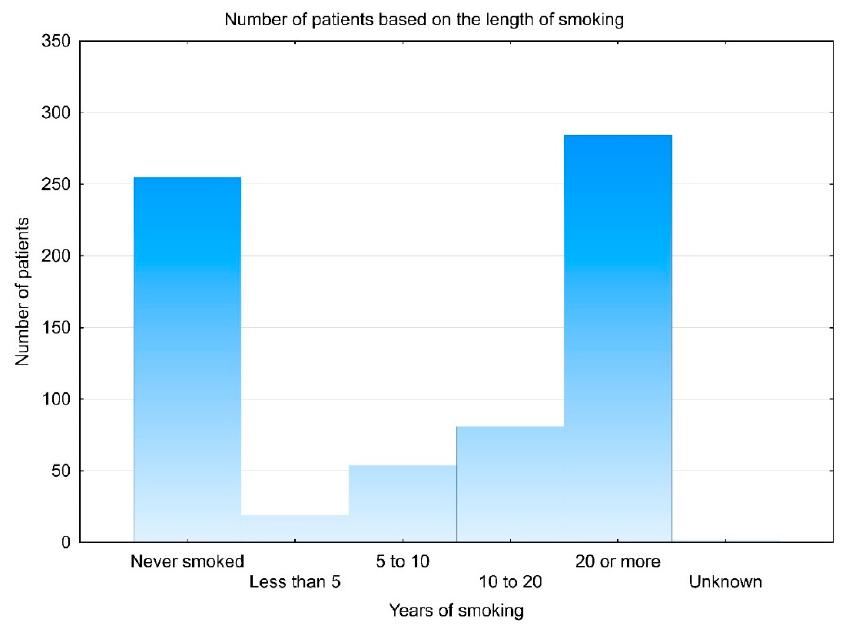
Figure 1. Number of patients based on the length of smoking in years. A similar number of patients reported never smoking ( N = 255) and smoking 20 years or more ( N = 284); both much higher numbers compared to patients who smoked for less than 5 years ( N = 19), from 5 to 10 years ( N = 52) and from 10 to 20 years ( N = 81). No data is available for four patients. Table 2. Further analysis of the characteristics of the patients who admitted to smoking at any period ( N = 441).